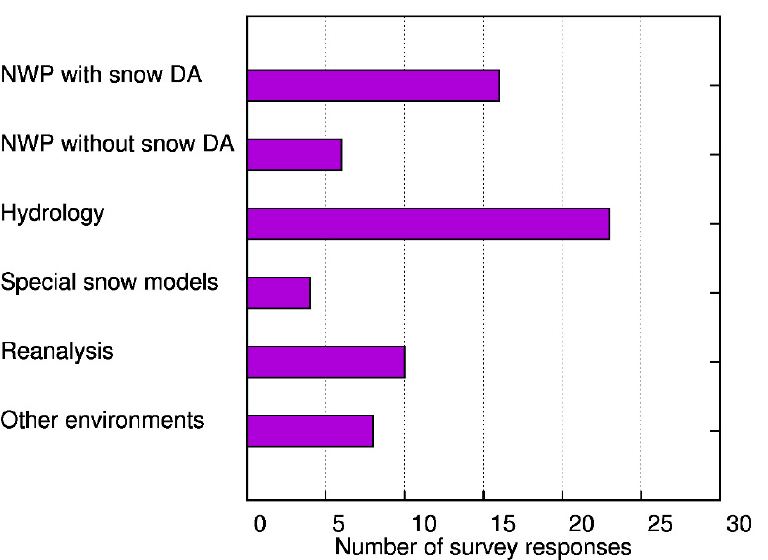
Figure 2. Distribution of modeling environment within the questionnaire.